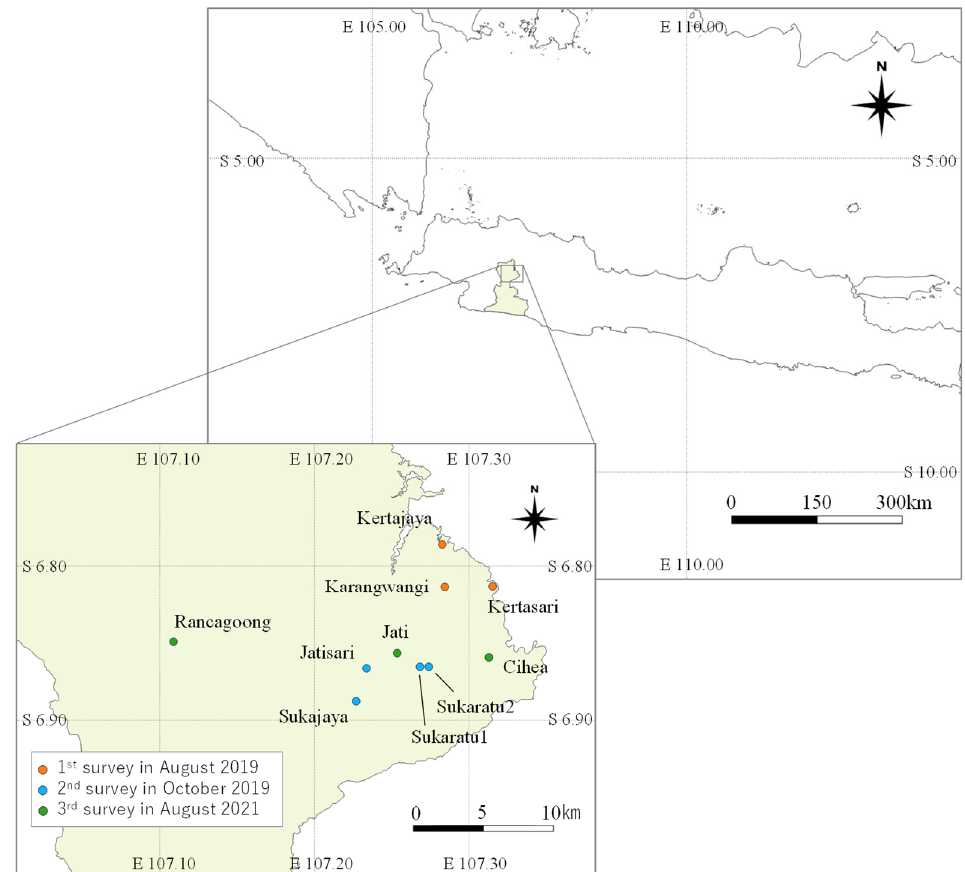
Figure 1. Map of the investigation site. The location names are indicated in the lower left map.